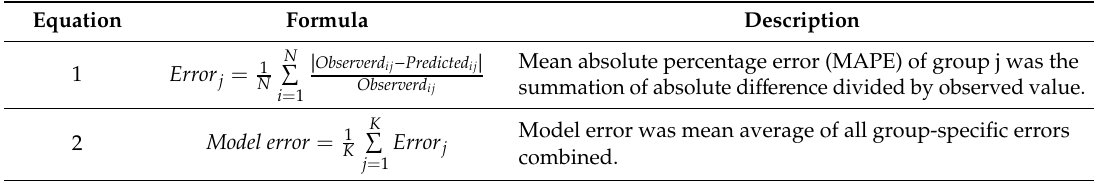
Table 5. Summary of the equations used to calculate model error. Equation Formula